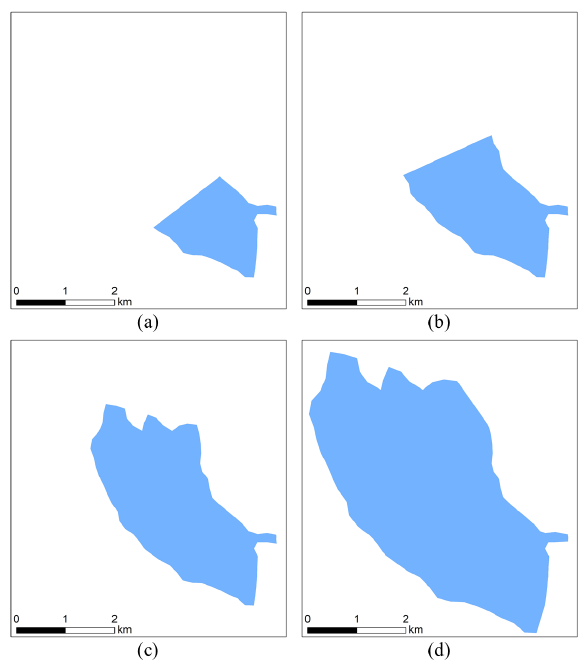
Figure 3. The beels with different surface areas considered for scenario development, with (a) 230ha, (b) 460ha, (c) 400ha, and (d)